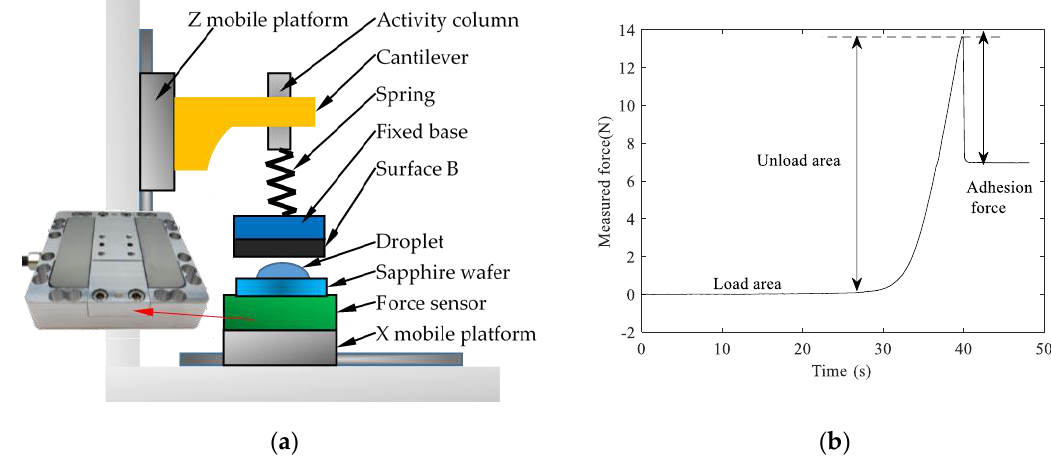
Figure 4. The test platform and the measurement curve structure: ( a ) structure diagram of triaxial force measuring platform; ( b ) the adhesion force measurement curve obtained by the test platform. Table 1. Surface parameters of different materials.